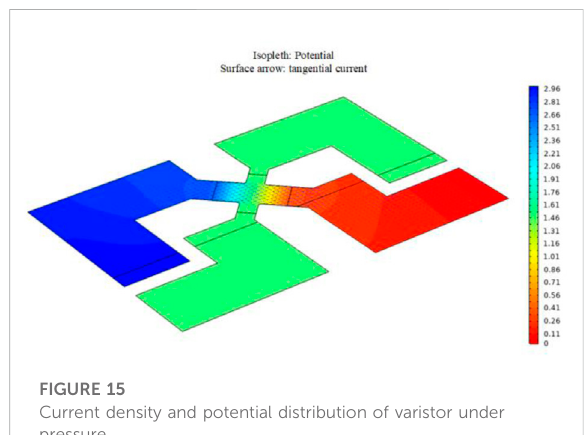
FIGURE 15 Current density and potential distribution of varistor under pressure.